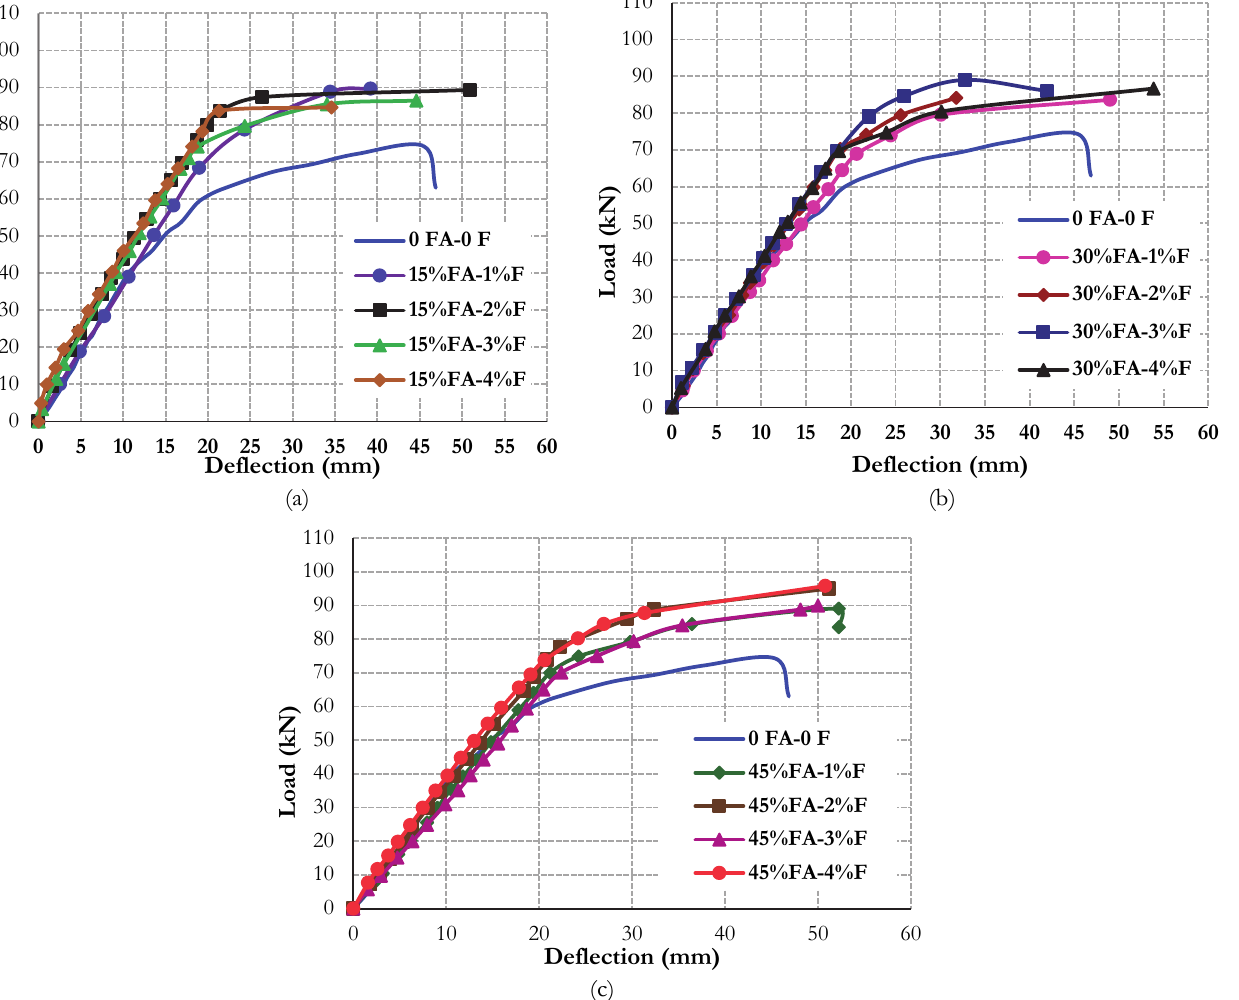
Figure 4: The backbone curves for the tested beams: (a) group1, (b) group2, and (c)